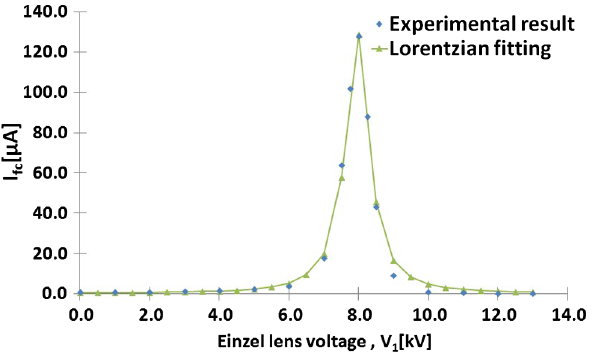
FIG. 22. Beam signal as observed with an ES bunch monitor in the DA